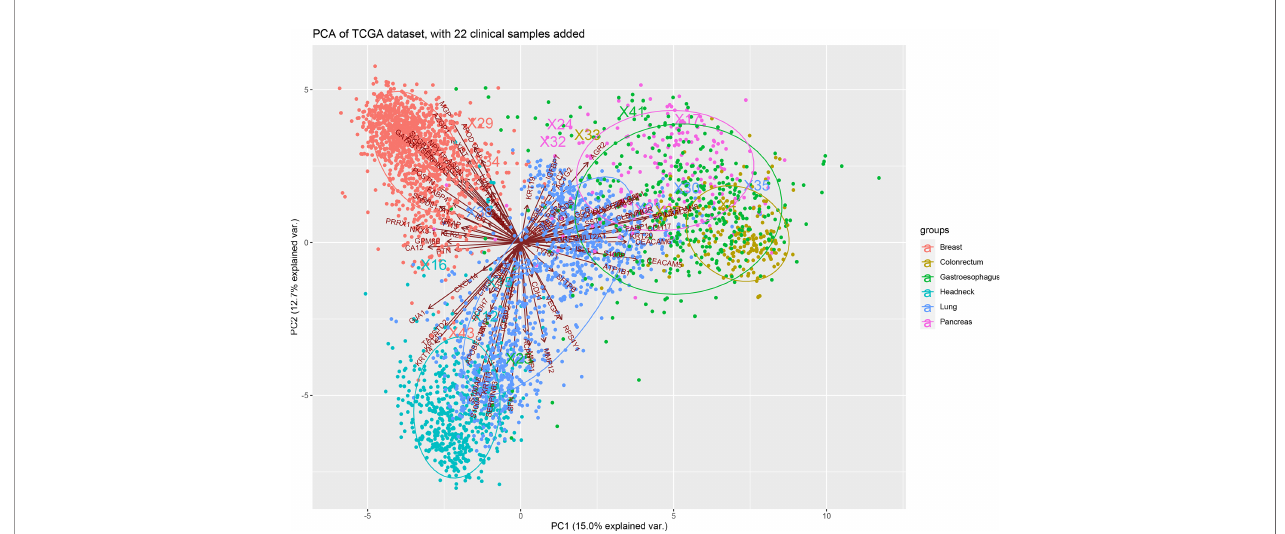
FIGURE 4 | Principal component analysis of 90-gene expression between CUP and primary tumor from TCGA database.